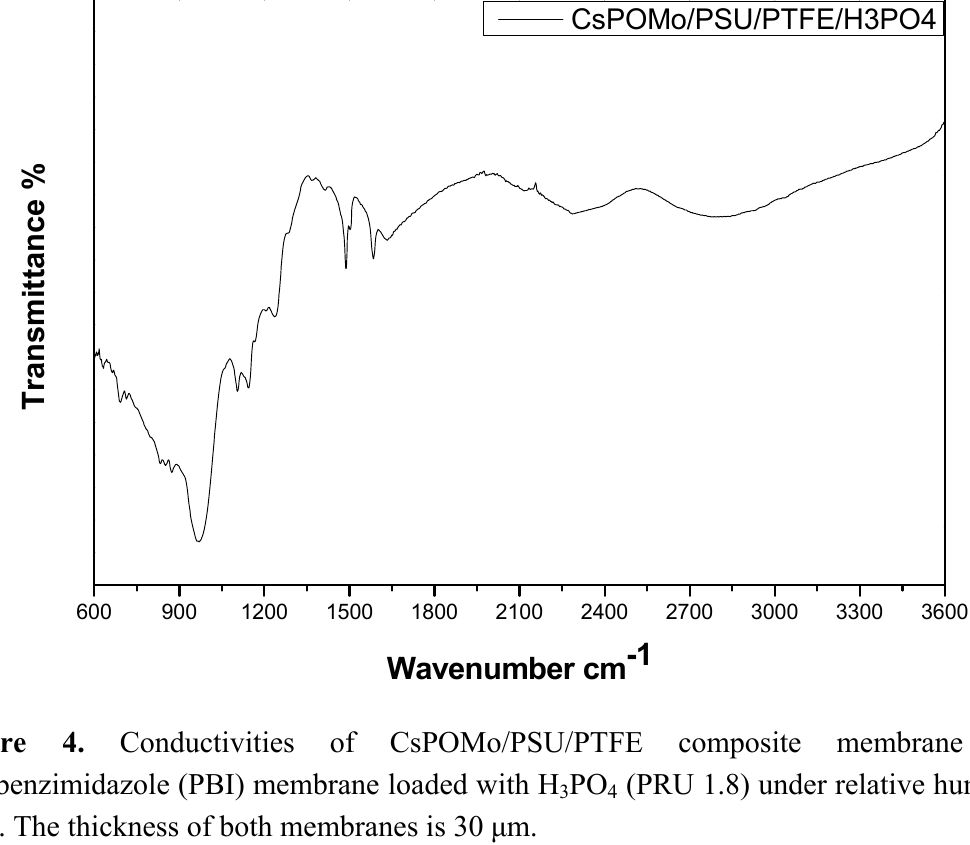
PO (PRU 1.8) under relative humidity 3 4